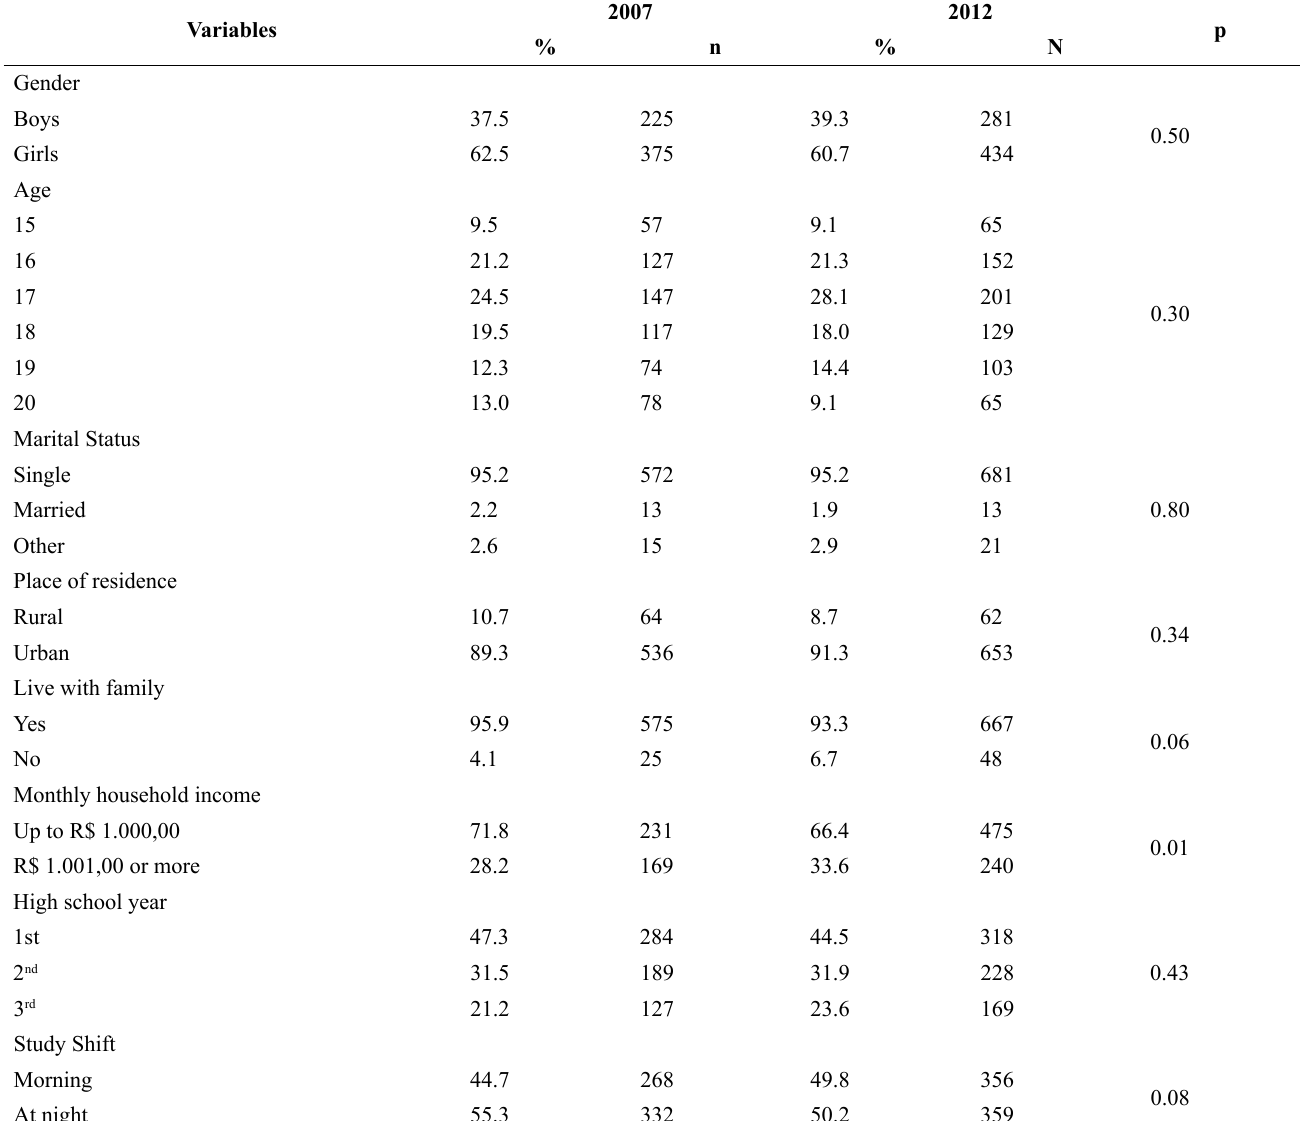
Table 1. Sociodemographic, economic, and school-related distribution of high school students in the public school network of Caruaru, PE, Brazil - 2007 (n = 600) and 2012 (n =